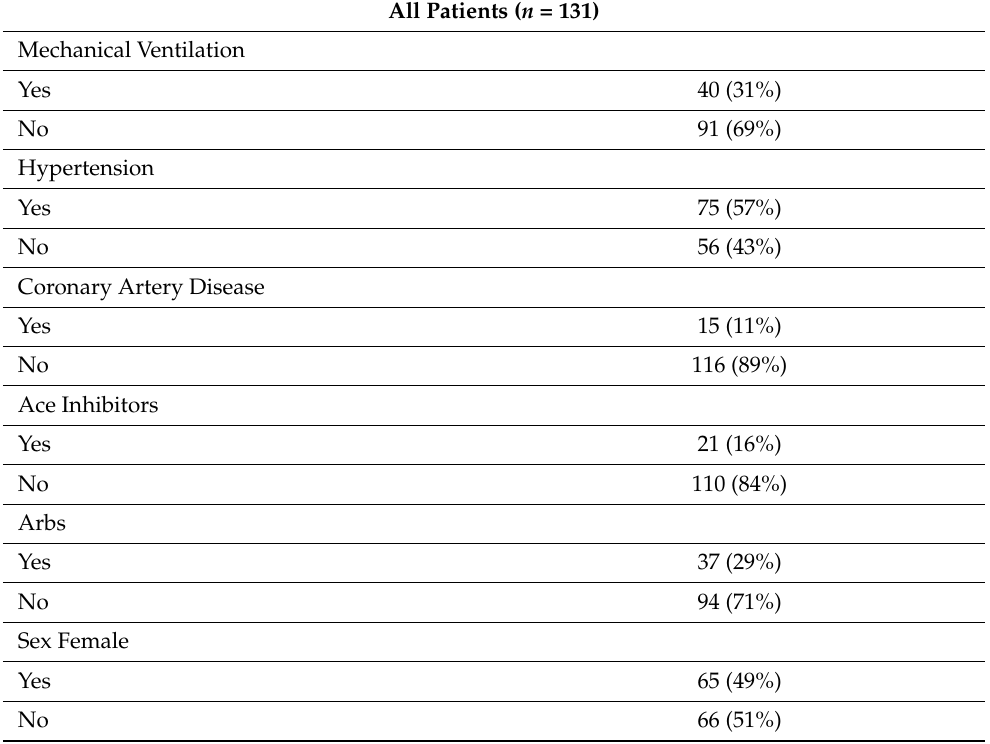
Table 2. Baseline characteristics of COVID-19 patients. ARBs = Angiotensin Receptors Blockers. All Patients ( n = 131)